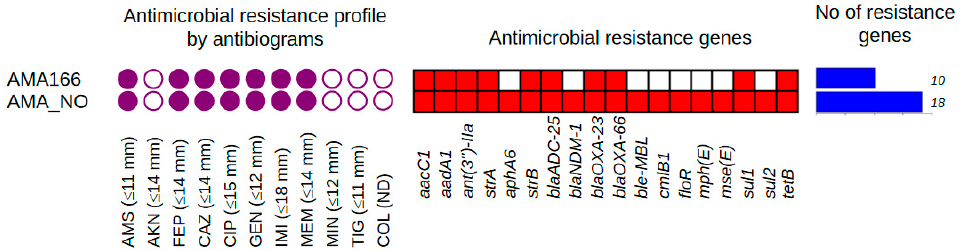
Figure 2. Comparison of antimicrobial susceptibility profile and antimicrobial resistance genes among AMA_NO and AMA166 strains. The figure is deposited in GitHub Repository (https://github.com/germant13/Traglia2023_AbST2_SARS.git (accessed on 9 February 2023). The ARGs bla NDM-1 (carbapenem resistance), floR (florfenicol/chloramphenicol resis- tance), sul2 (sulfonamide resistance), ble MBL (bleomycin resistance), msrE (macrolide